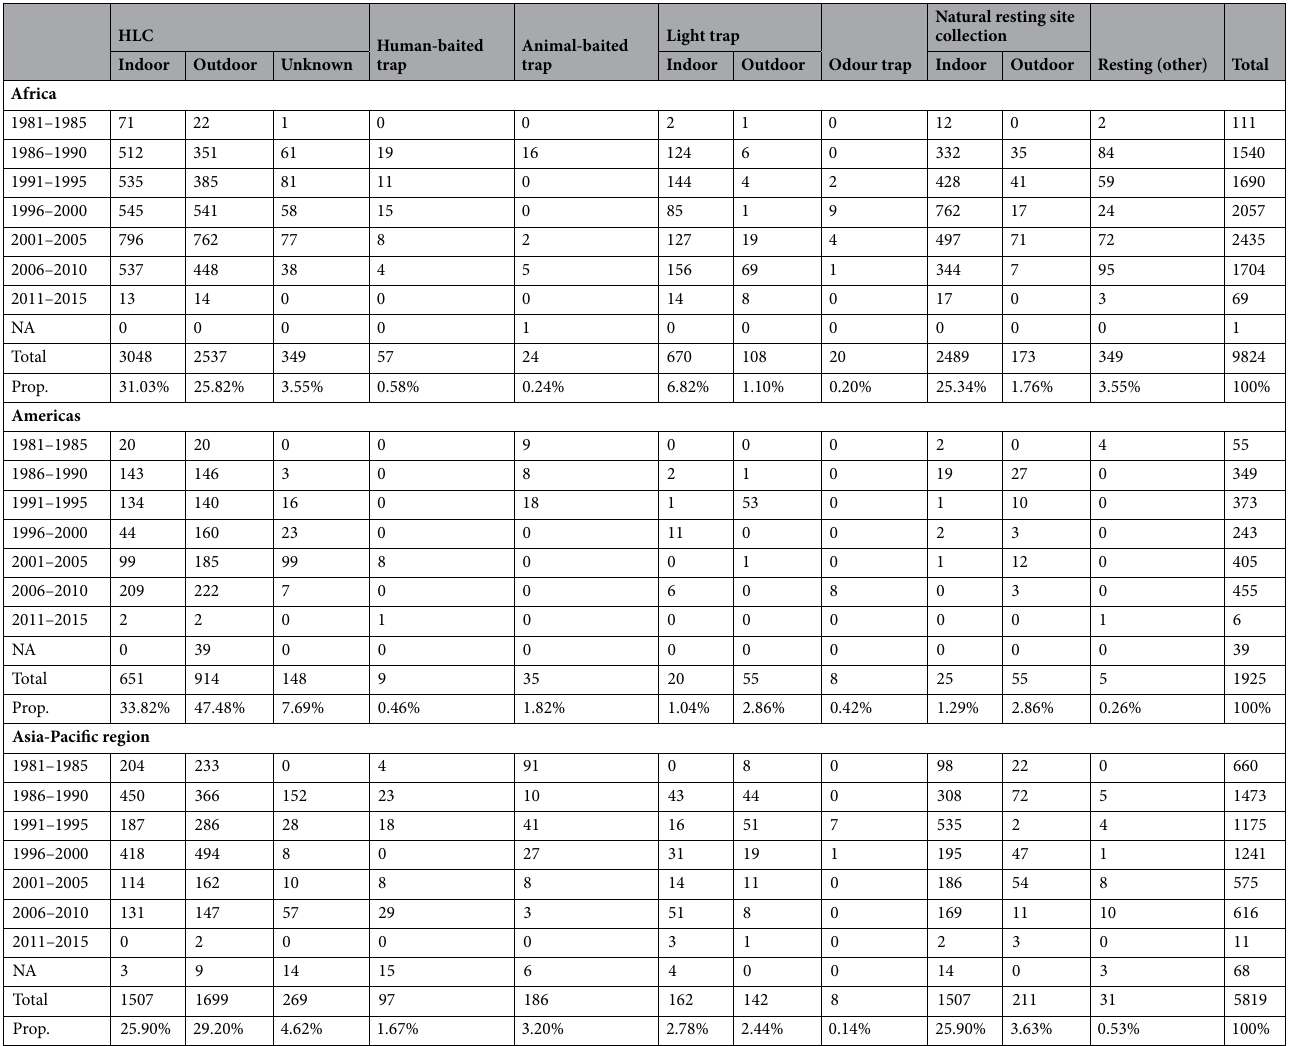
Table 3. The number of data records for each collection method used in Africa, the Americas and the Asia- Pacific region, categorised by 5-year